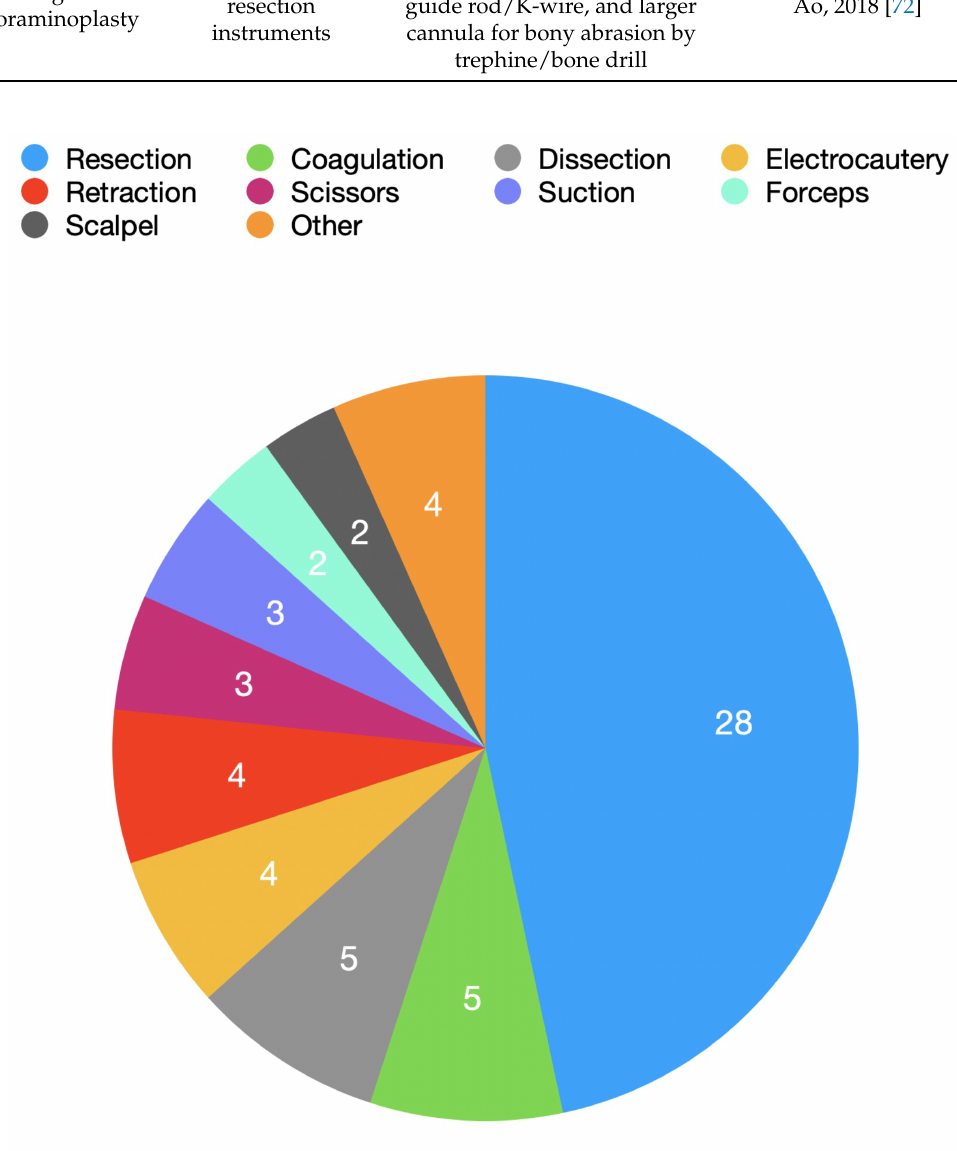
Figure 4. Number of novel instruments identified by function of instrument. Seven available instruments, the XS Micro Instruments, Modified Suction Tip, Marburg Electrosurgical Probe, Harmonic Scalpel, Bipolar Microforceps, Bipolar Microscissors and the Handpiece, Keyhold, and Needle-Type Probes and Probe Sheaths for use with the Ultrasonic Surgical Unit were reported for general use with multiple functions. An additional nine instruments were reported for specific approaches or procedures and capable of performing specialised single-functions: two instruments were designed for endoscopic third ventriculostomy to dilate the floor of the third ventricle; one